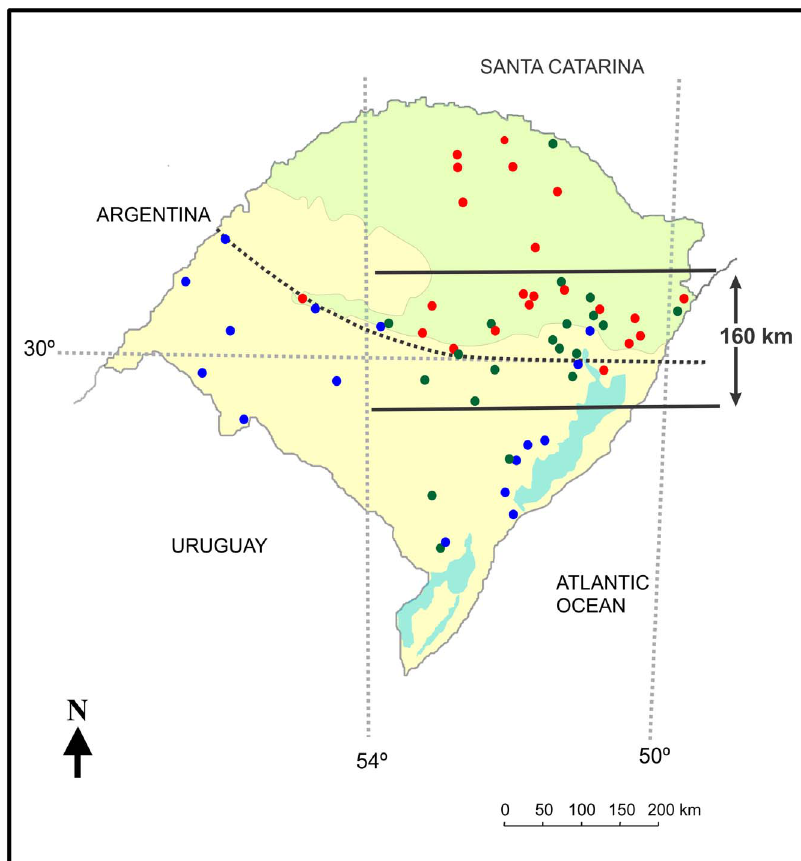
Figure 4. Spatial distribution of samples collected in RS state, including their genetic identification as pure L.guttulus (red circles), pure L.geoffroyi (blue circles), and hybrids (green circles). Background colors on the map correspond to the two biomes found in RS state: Atlantic Forest (green) and Pampa (tan). The area delimited by the thick lines correspond to a central region spanning ca. 160 km in a north-south direction, between longitudes 50 u W and 54 u W, where the highest concentration of genetically identified hybrids was observed. The dashed black line at the center of the map, lying on parallel 30 u S on its eastern side and shifting towards the north on the western end, corresponds to the geographic limit between the distributions of the two cat species [18]. This line was used to evaluate the spatial distribution of genetic and morphological variables (see Figure 6).